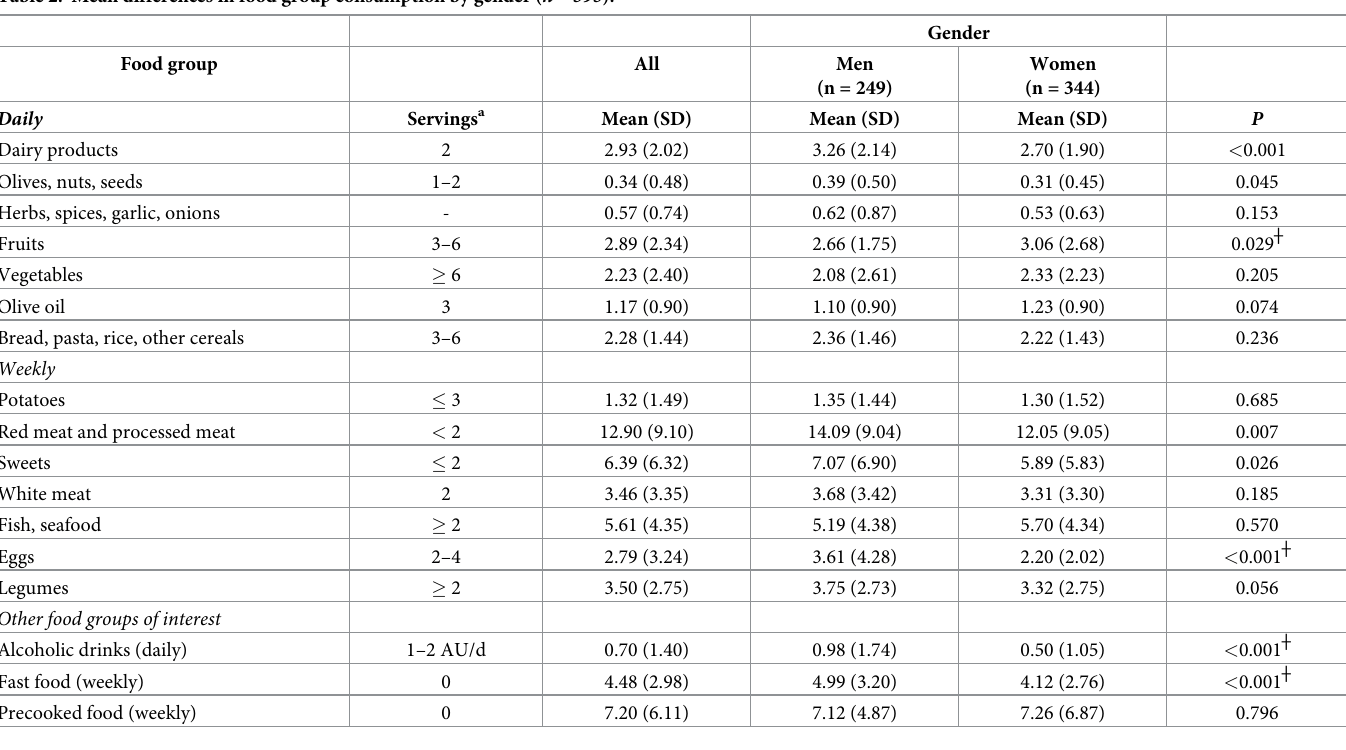
Table 2. Mean differences in food group consumption by gender ( n =